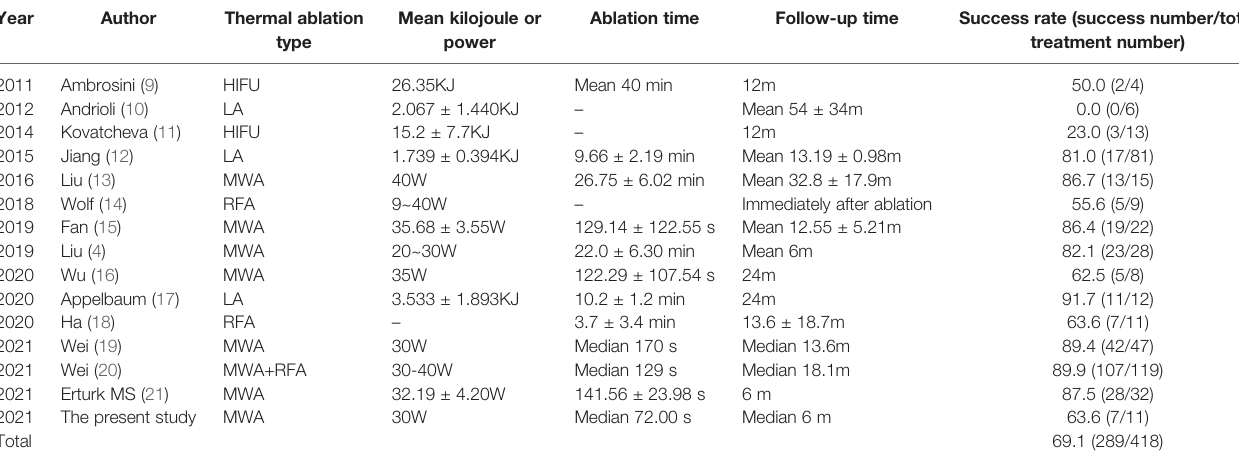
TABLE 1 | Summary of thermal ablation studies in the treatment of PHPT from